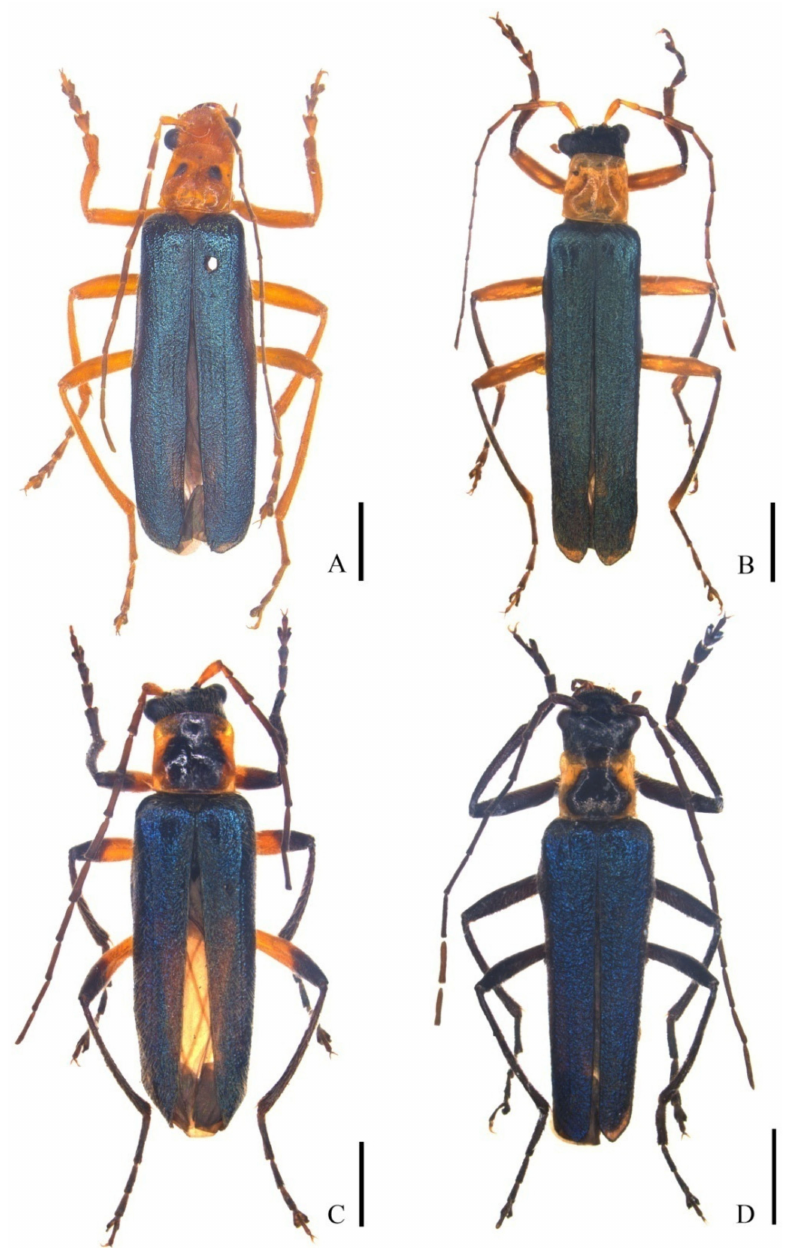
Figure 1. Male habitus, dorsal view: ( A ) Lycocerus bimaculaticollis sp. nov. ; ( B ) L. testacicollis sp. nov. ; ( C ) L. daliensis sp. nov. ; ( D ) L. vietnamensis sp. nov. Scale bars: ( A ) 2.0 mm; ( B – D ) 5.0